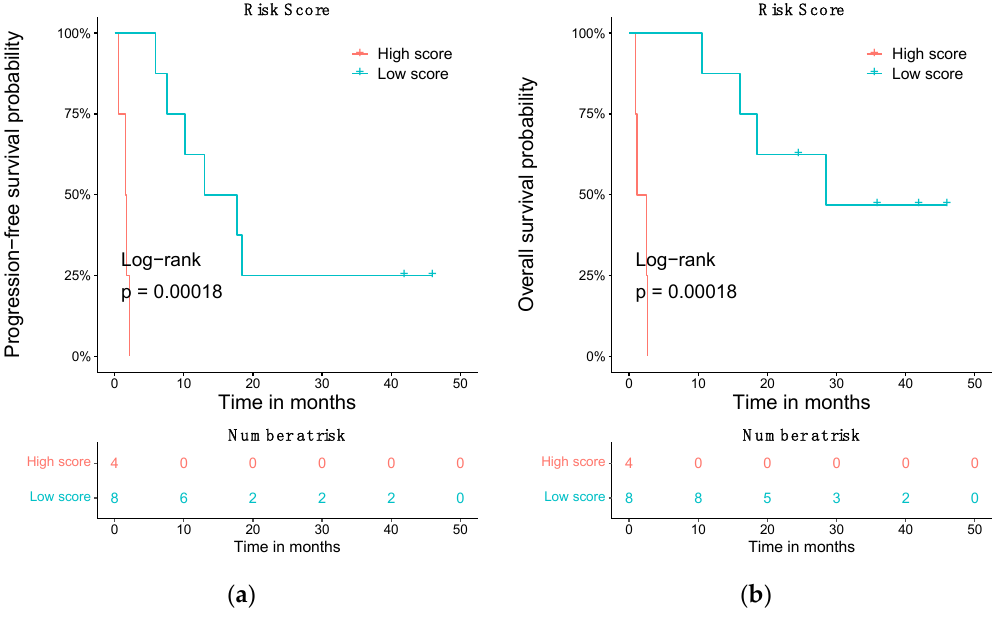
Figure 7. Prognostic value of the ceRNA signature. ( a ) Association of the ceRNA Risk score based on gene expression levels with overall survival in cutaneous metastatic melanoma. ( b ) Stratification of the patients according to PFS using the ceRNA-based risk score.